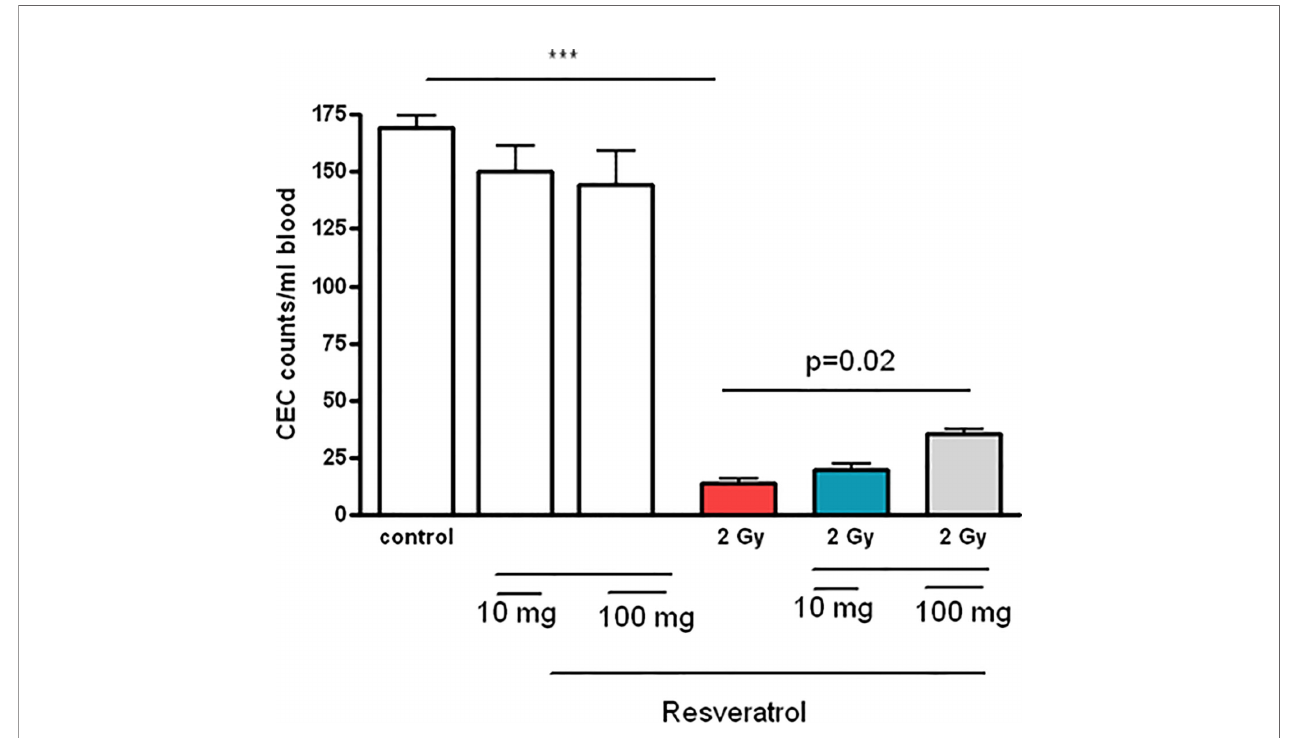
FIGURE 6 | Effects of resveratrol treatment (10 and 100 mg/kg body weight) on the CEC counts of peripheral blood after rats ’ irradiation with 2 Gy ***p < 0.001. Pretreatment with resveratrol enhanced the CEC counts in peripheral blood, which implies radioprotective